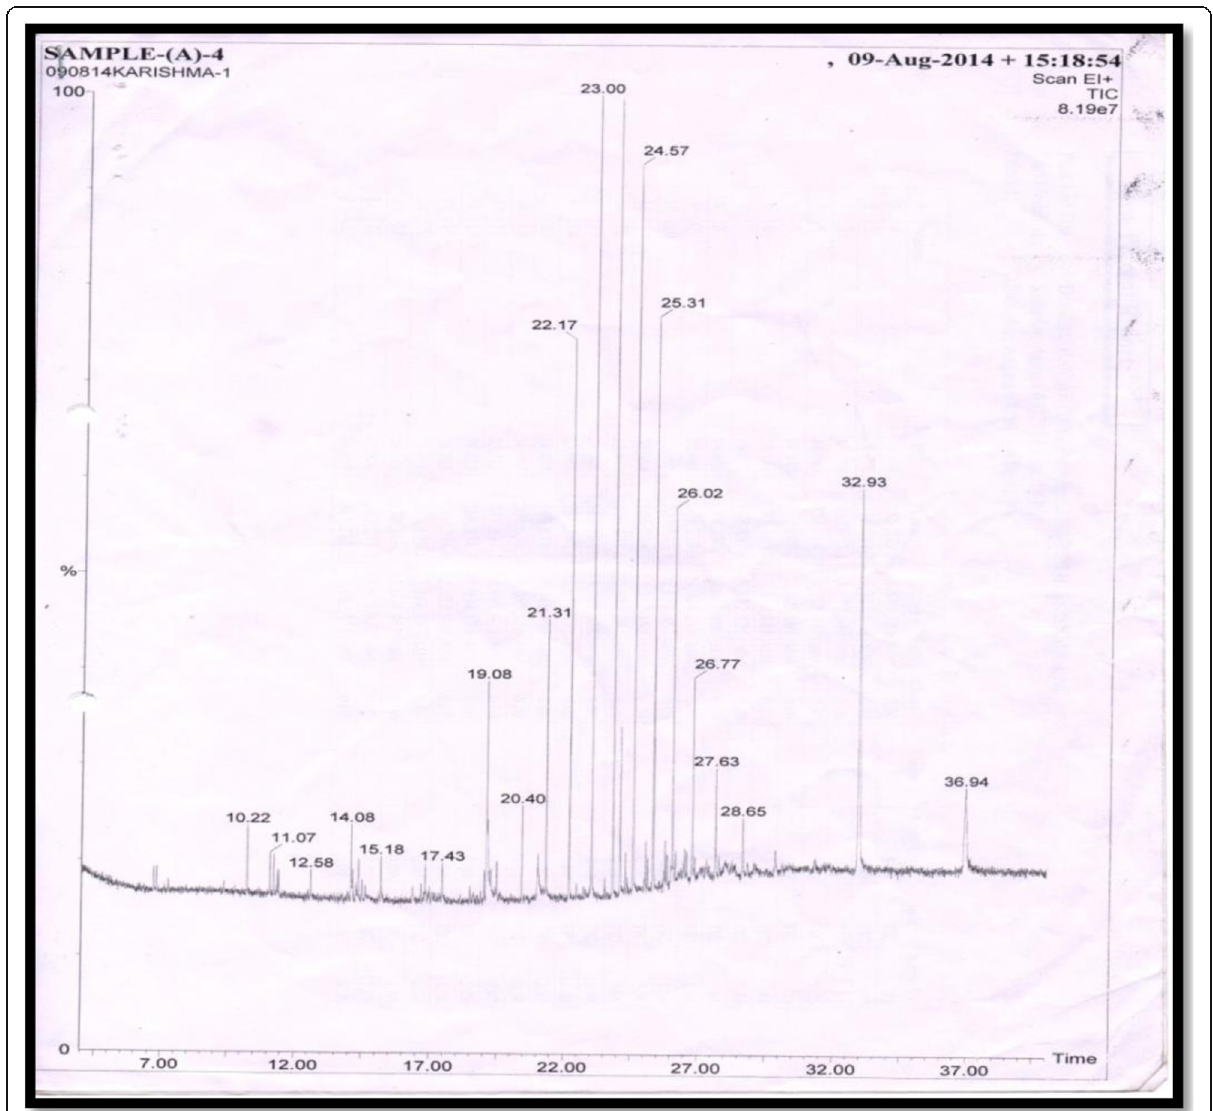
Fig. 4 GC-MS analysis of methanolic extract of Praecitrullus fistulosus